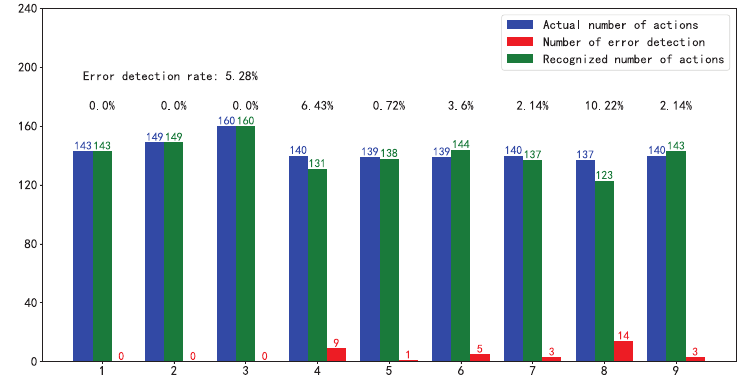
Figure 7. Motion